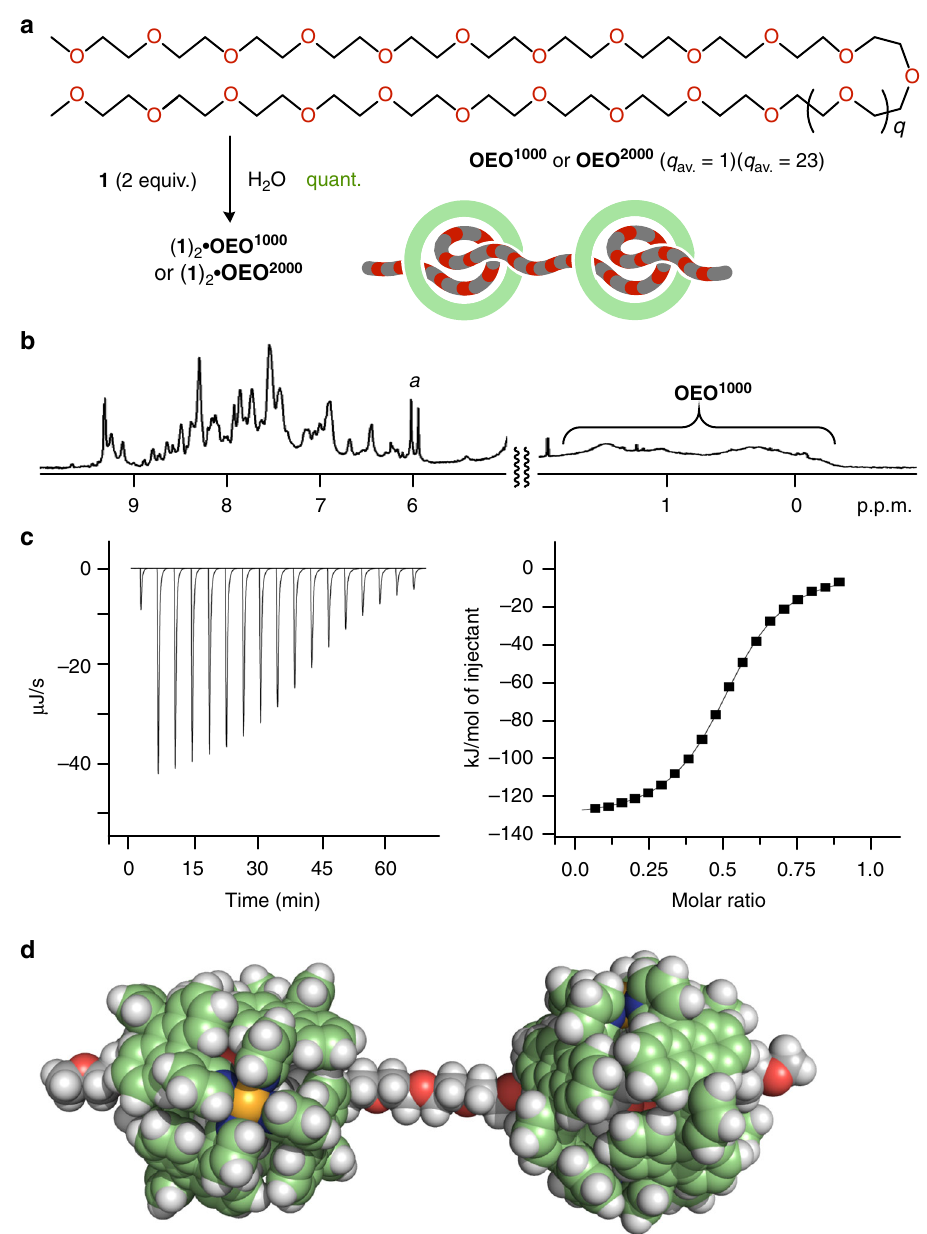
Fig. 6 Formation and characterization of 2:1 host – guest complexes ( 1 ) 2 (cid:129) OEO 1000 and ( 1 ) 2 (cid:129) OEO 2000 in a threading fashion. a Schematic representation of the formation of pseudo-rotaxane-shaped 2:1 host – guest complexes ( 1 ) 2 (cid:129) OEO 1000 and ( 1 ) 2 (cid:129) OEO 2000 in water. b 1 H NMR spectrum (500 MHz, D 2 O, room temperature) of ( 1 ) 2 (cid:129) OEO 1000 . c ITC thermogram and binding isotherm (H 2 O, 298 K) of OEO 1000 toward capsule 1 . d Optimized structure of ( 1 ) 2 (cid:129) OEO 1000 ( q = 1) (the peripheral substituents are replaced by hydrogen atoms for